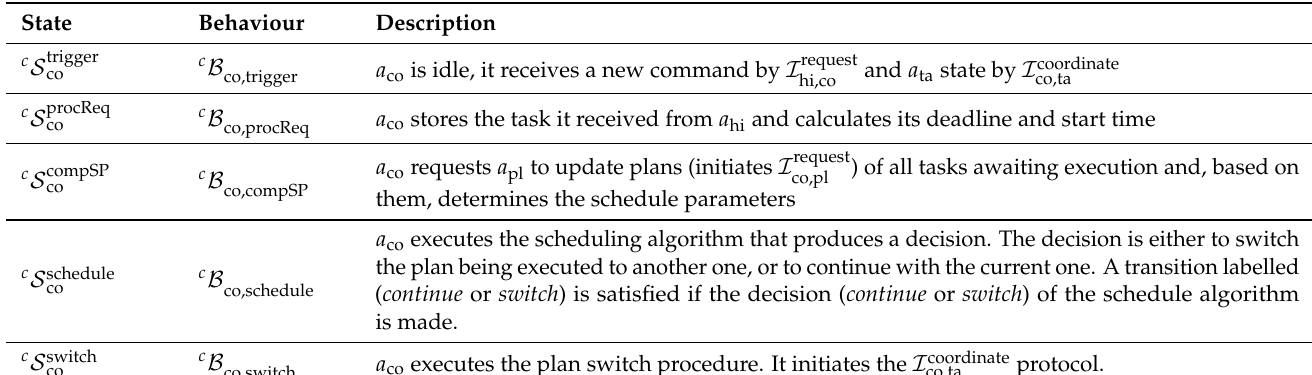
Table 3. Mapping of the states of c co FSM to a co behaviours.